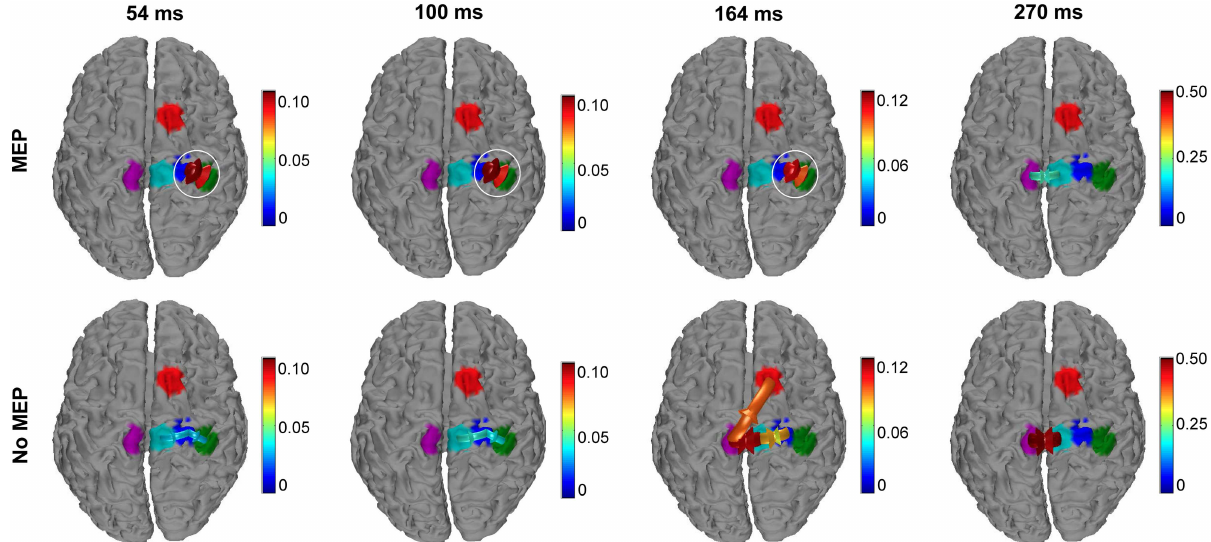
Fig 8. Connectivity amongst ROIs for right M1 stimulation. Arrows indicatesignificantconnectivity betweenROIs at the 54ms (left), 100ms (middle left), 164 ms (middle right), and 270 ms (right) latencies(averageof 11 participants with simultaneous EMG recording). The color of the arrow indicatesthe strength of the connection. White circles emphasizedifferences in connectivity patterns amongst trials with MEPs (top) and without MEPs (bottom).